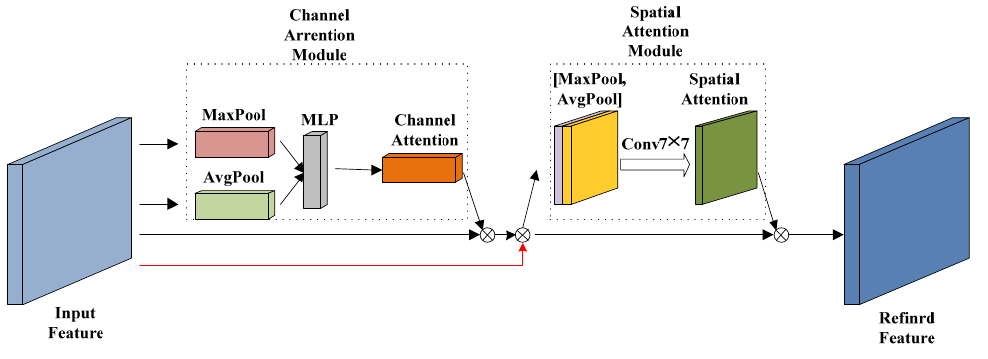
Figure 4. Improved attention mechanism module.